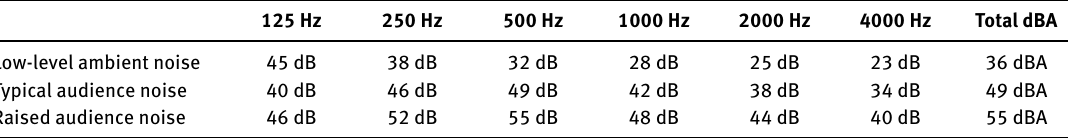
Table 3. Applied in calculation noise levels (Vassilantonopoulos & Mourjopoulos, 2003). 125 Hz 250 Hz 500 Hz 1000 Hz 2000 Hz 4000 Hz Total dBA Low-level ambient noise 45